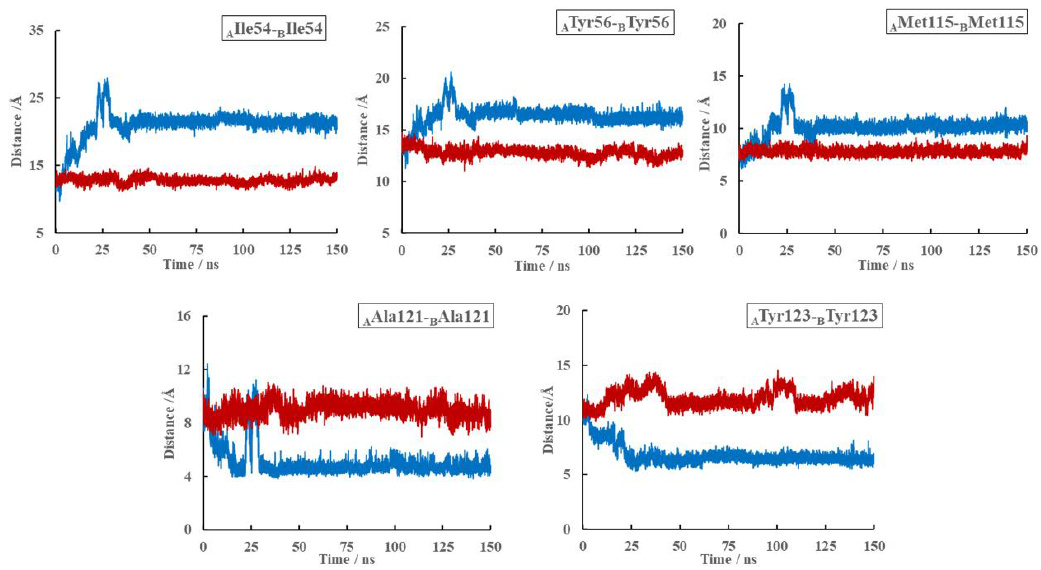
Figure 9. Distances of the key residue pairs of the dimer (blue) and S (red) systems over the whole 0–150 ns MD simulation period.